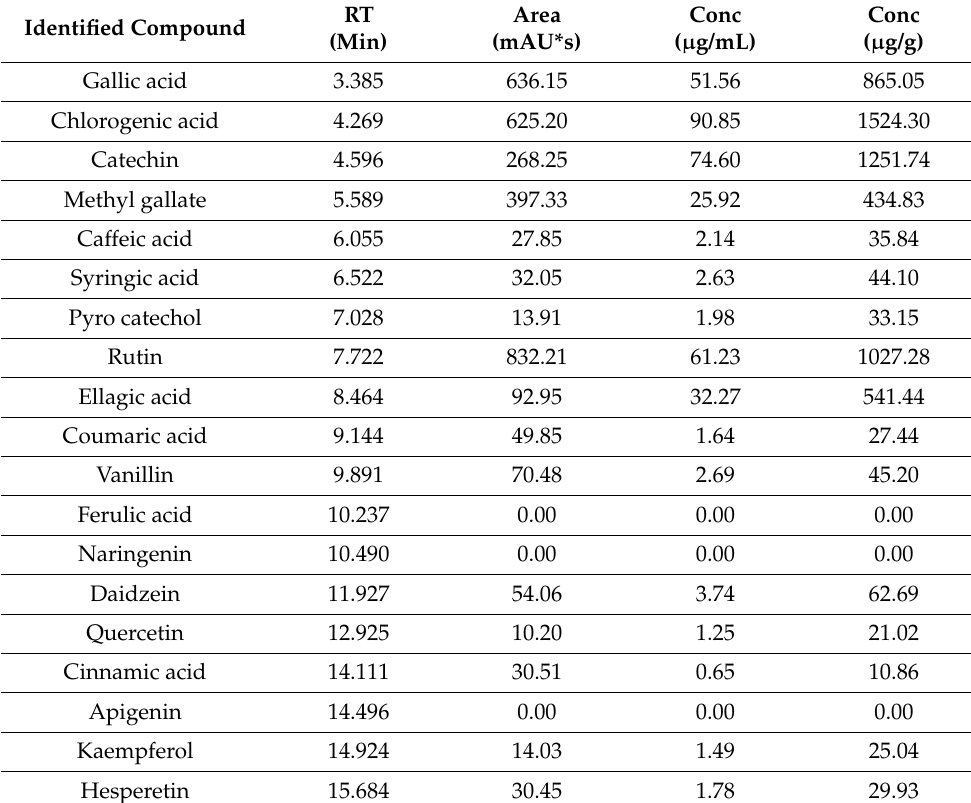
Figure 2. Cytotoxicity curve of SCRE (with CC 50 of 70.36 ± 0.8 µg/mL). The results are exhibited as mean ± SD.